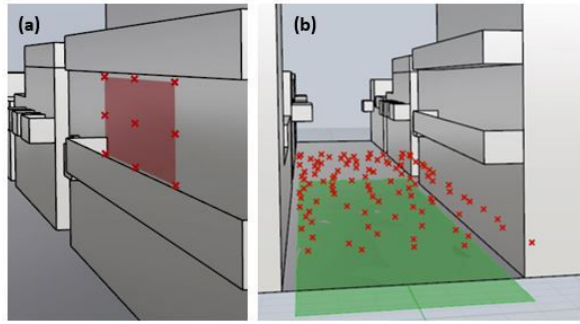
Figure 3: (a) Mesh used for a receiver; (b) Modelling the relevant sources for the